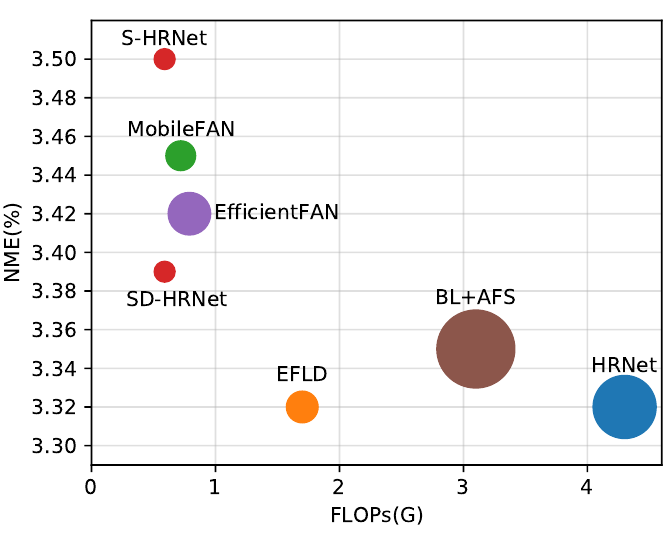
Figure 1. Comparison of the computational cost (i.e., FLOPs) and the performance (i.e., NME) on 300W between the proposed approach and existing state-of-the-art methods. The size of a circle represents the number of parameters. Our approach (SD-HRNet) achieves a better trade-off between accuracy and efficiency than its